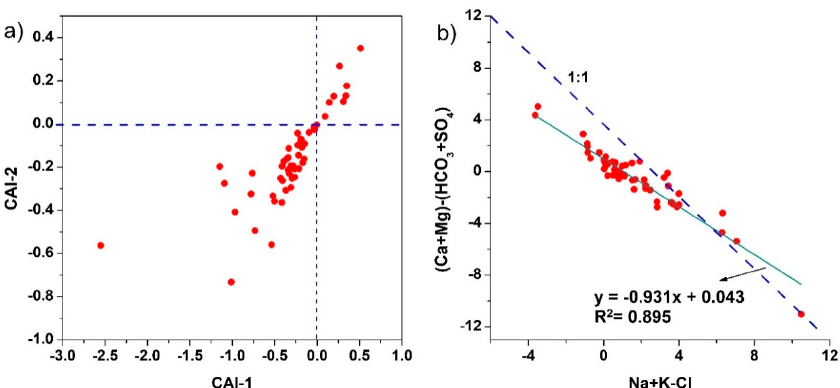
Figure 7. Plots showing ( a ) CAI-1 versus CAI-2; ( b ) (Ca 2+ + Mg 2+ ) − (HCO 3 − + SO 42 − ) versus (Na + + K + ) − Cl − .